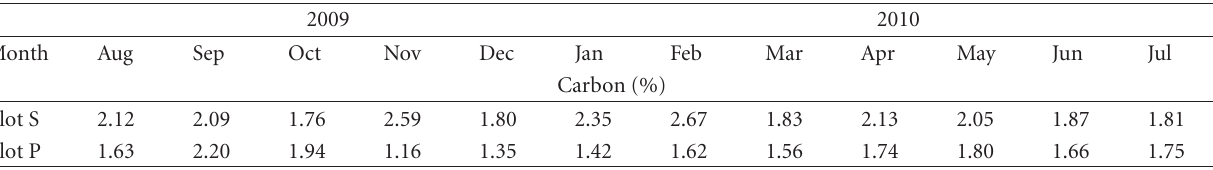
Table 5: Changes of soil carbon content at plot P and plot